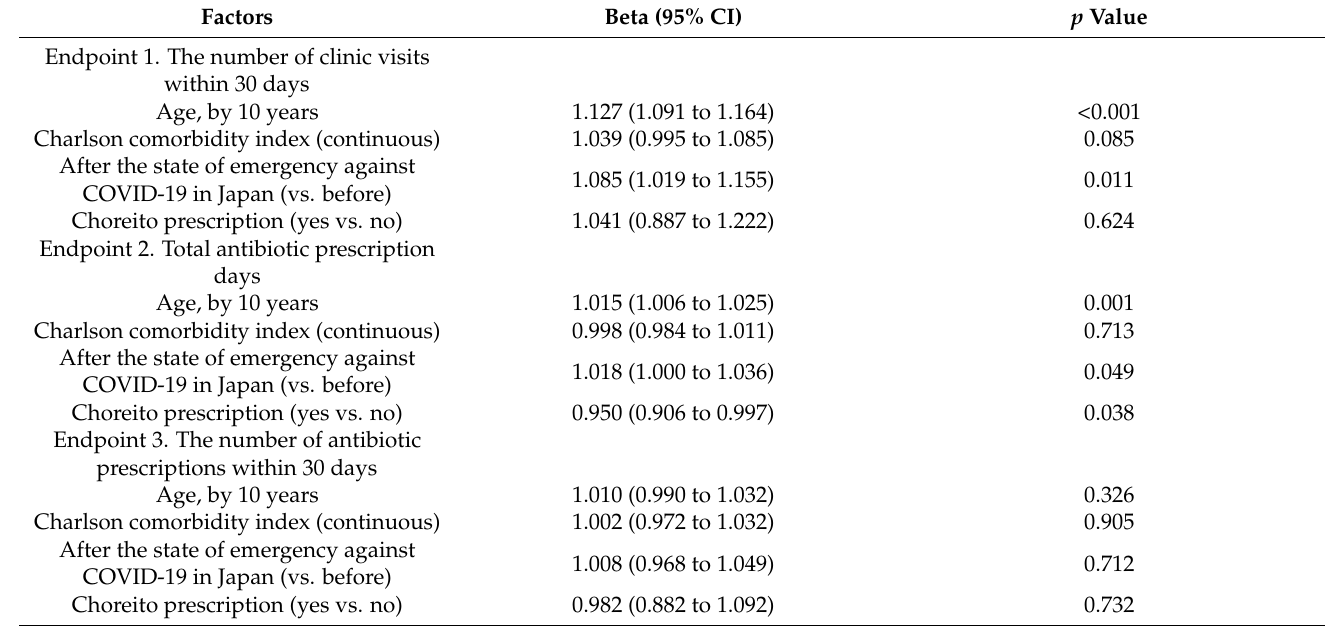
Table 2. Multivariable Poisson regression analyses of 8834 patients who were prescribed antimicro- bials for acute cystitis with or without Choreito (Kampo